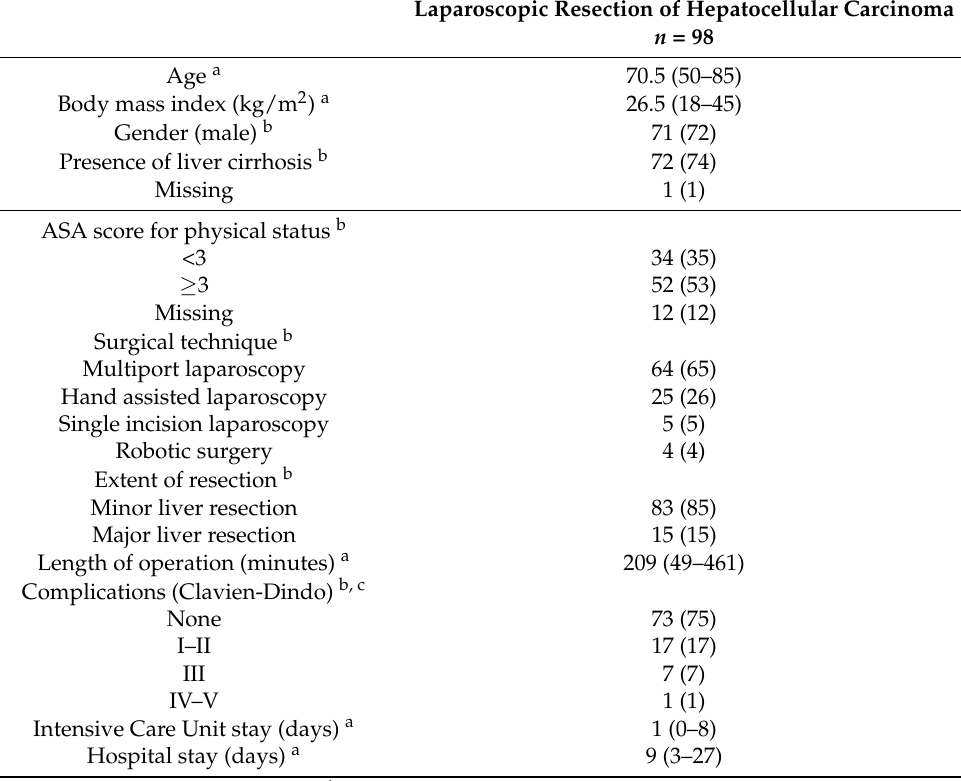
Table 1. Patients’ characteristics, surgical techniques, and perioperative outcomes after laparoscopic liver resection for hepatocellular carcinoma